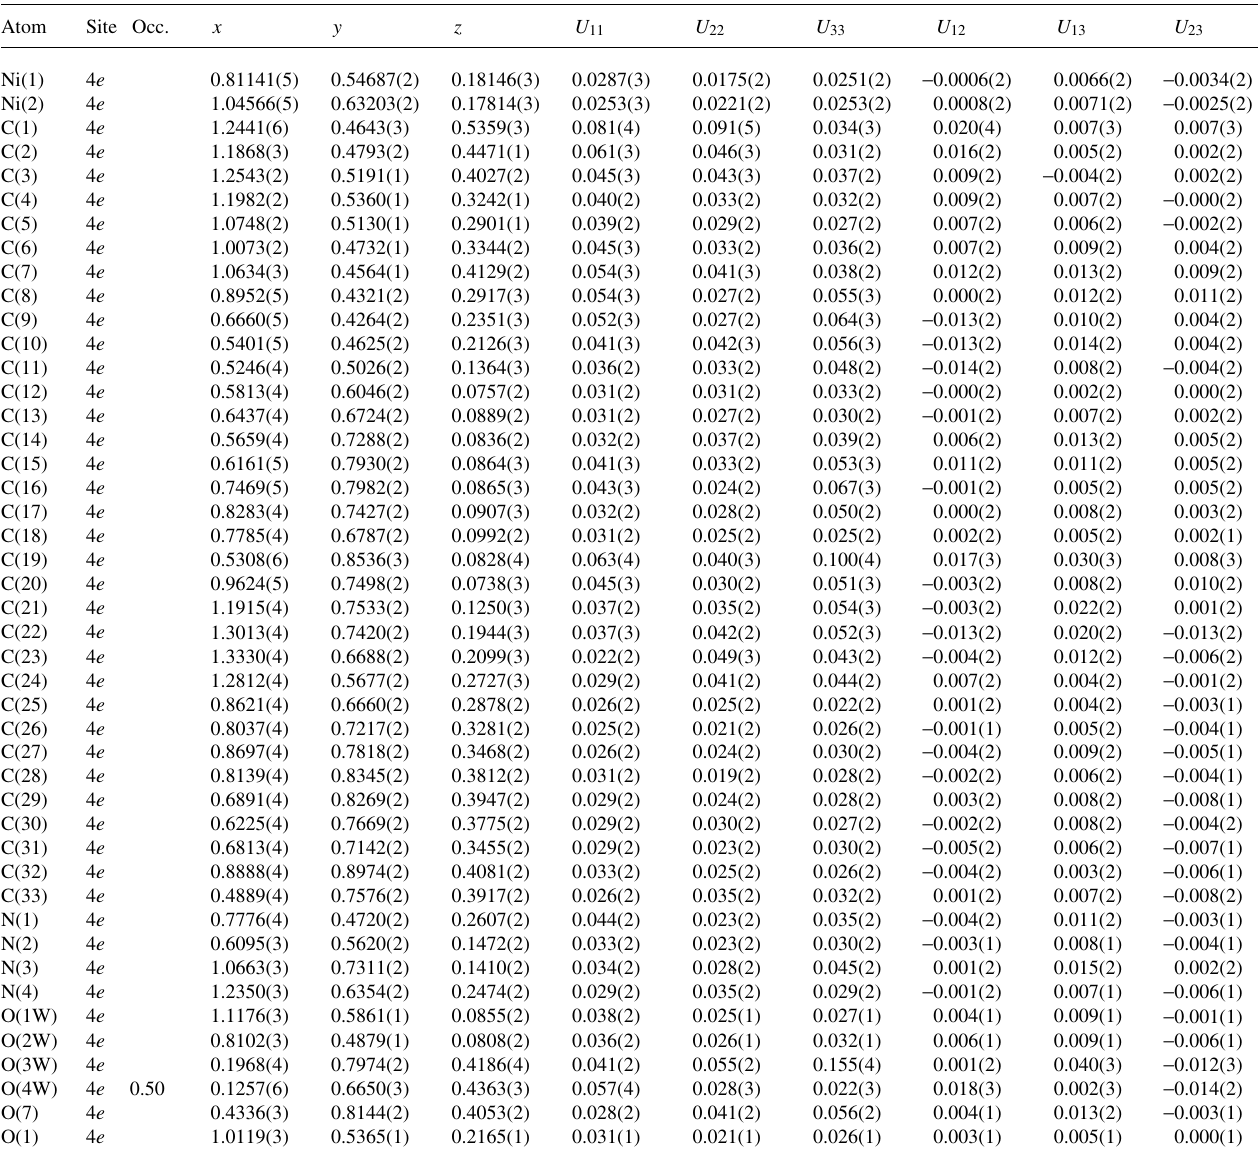
Table 3. Atomic coordinates and displacement parameters (in Å 2 )